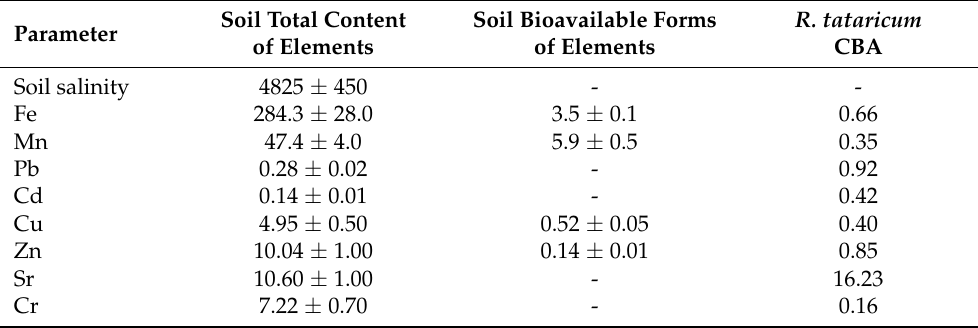
Table 5. R. tataricum coefficients of biological accumulation (CBA) in accordance with the correspon- dent soil data (mg kg − 1